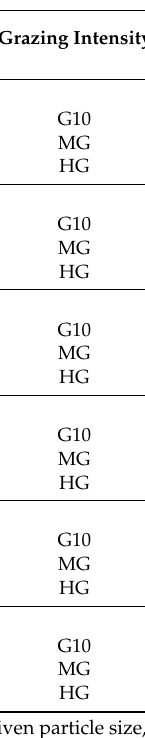
di ff erences among di ff erent soil layers at p ≤